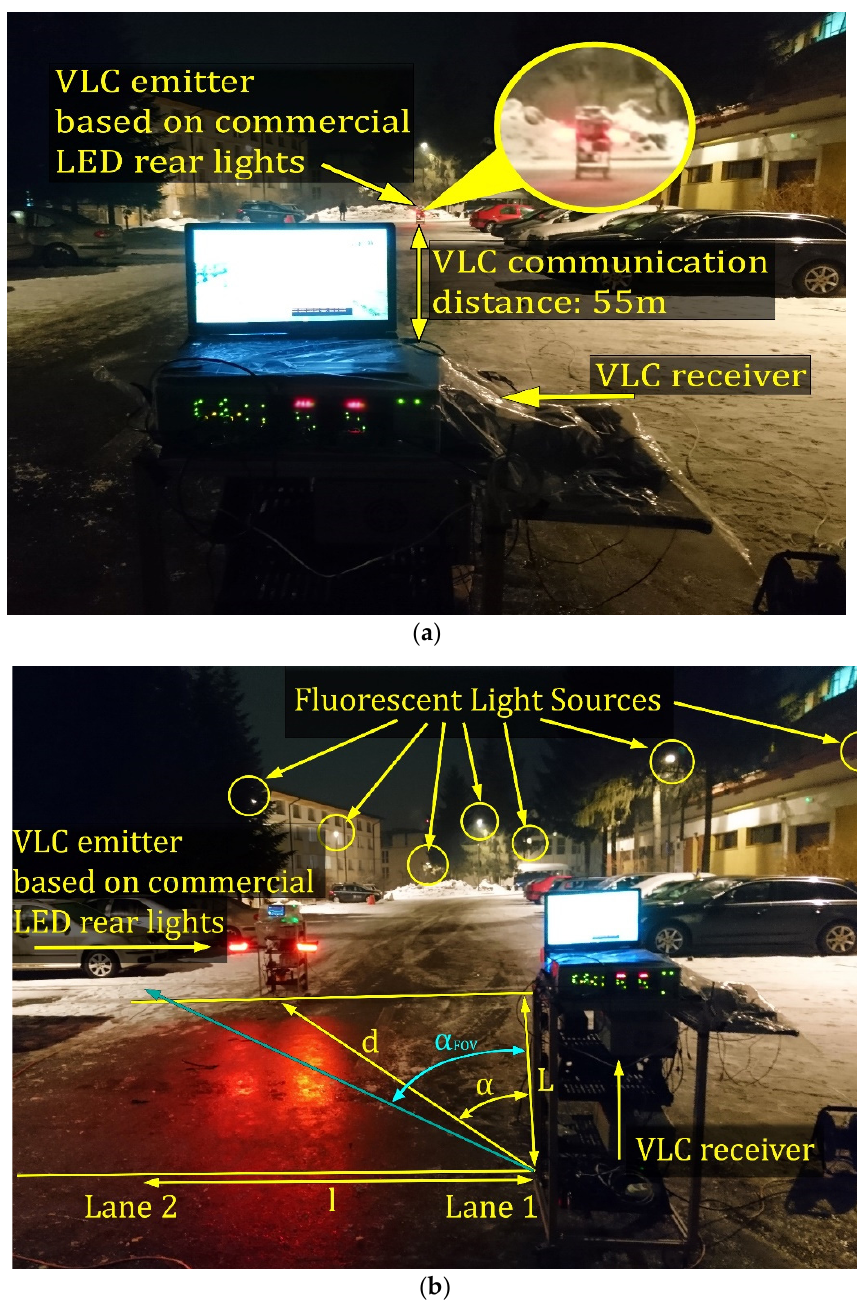
Figure 8. Outdoor experimental testing setup with the VLC emitter and the VLC receiver on the same lane ( a ), and on adjacent lanes ( b ). Table 3. Summary of the experimental parameters.